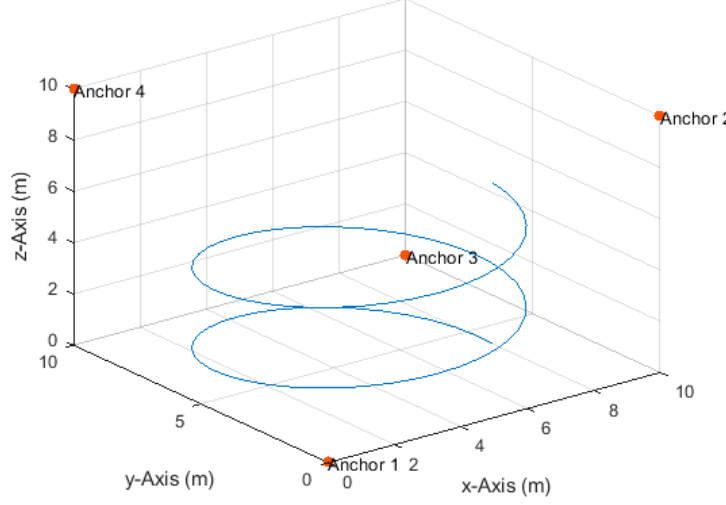
Figure 14. Anchor node arrangement and the helical path.